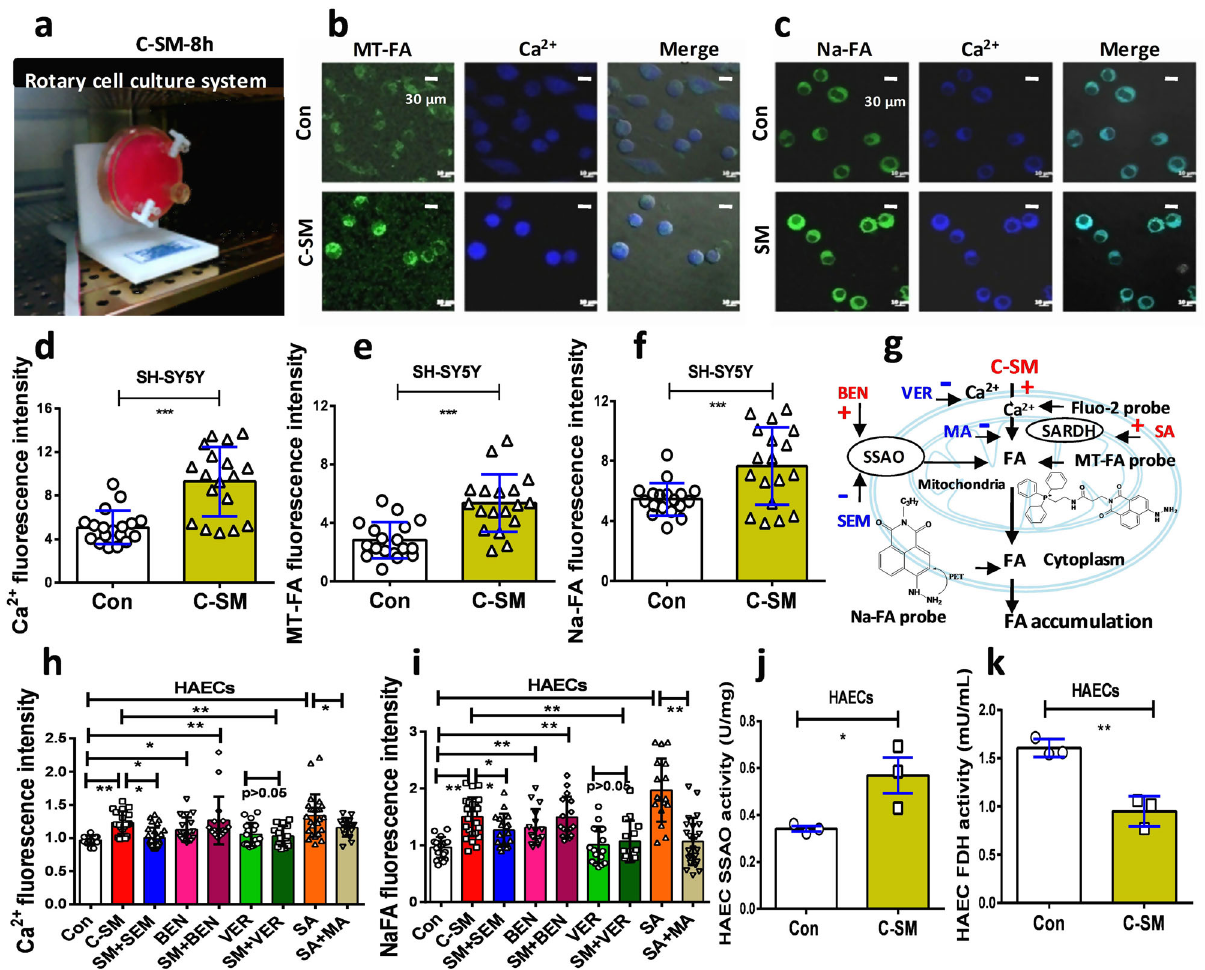
Fig. 3 Microgravity promoted formaldehyde generation by affecting intracellular Ca2 + and FA metabolism in vitro. a Simulated microgravity model of human SH-SY5Y cells in a rotary cell culture system. C-SM: simulated microgravity in the cultured cells. b , c Mitochondrial or cytoplasmic formaldehyde and intracellular Ca 2 + detected by confocal imaging. Scale bar = 30 μ m. d – f Statistical analysis of cellular Ca 2 + in fl ux, mitochondrial formaldehyde, and cytoplasmic formaldehyde ( n = 18). 8 h: 8 h. g Cell model of the effects of the different medicines on FA metabolism and intracellular Ca 2 + levels. FA formaldehyde, SSAO semicarbazide-sensitive amine oxidase, SARDH sarcosine dehydrogenase, BEN benzylamine, MA methoxyacetic acid, SA sarcosine, SEM semicarbazide, VER verapamil. h , i Changes in the levels of intracellular Ca 2 + and FA in the cultured HAECs after different medicines treatments, respectively. HAECs human aortic endothelial cells. j , k Changes in the activity of SSAO and FDH in the cultured HAECs. (Repeated three times). Error bars show the mean ± SEM; * p < 0.05, ** p < 0.01, *** p <